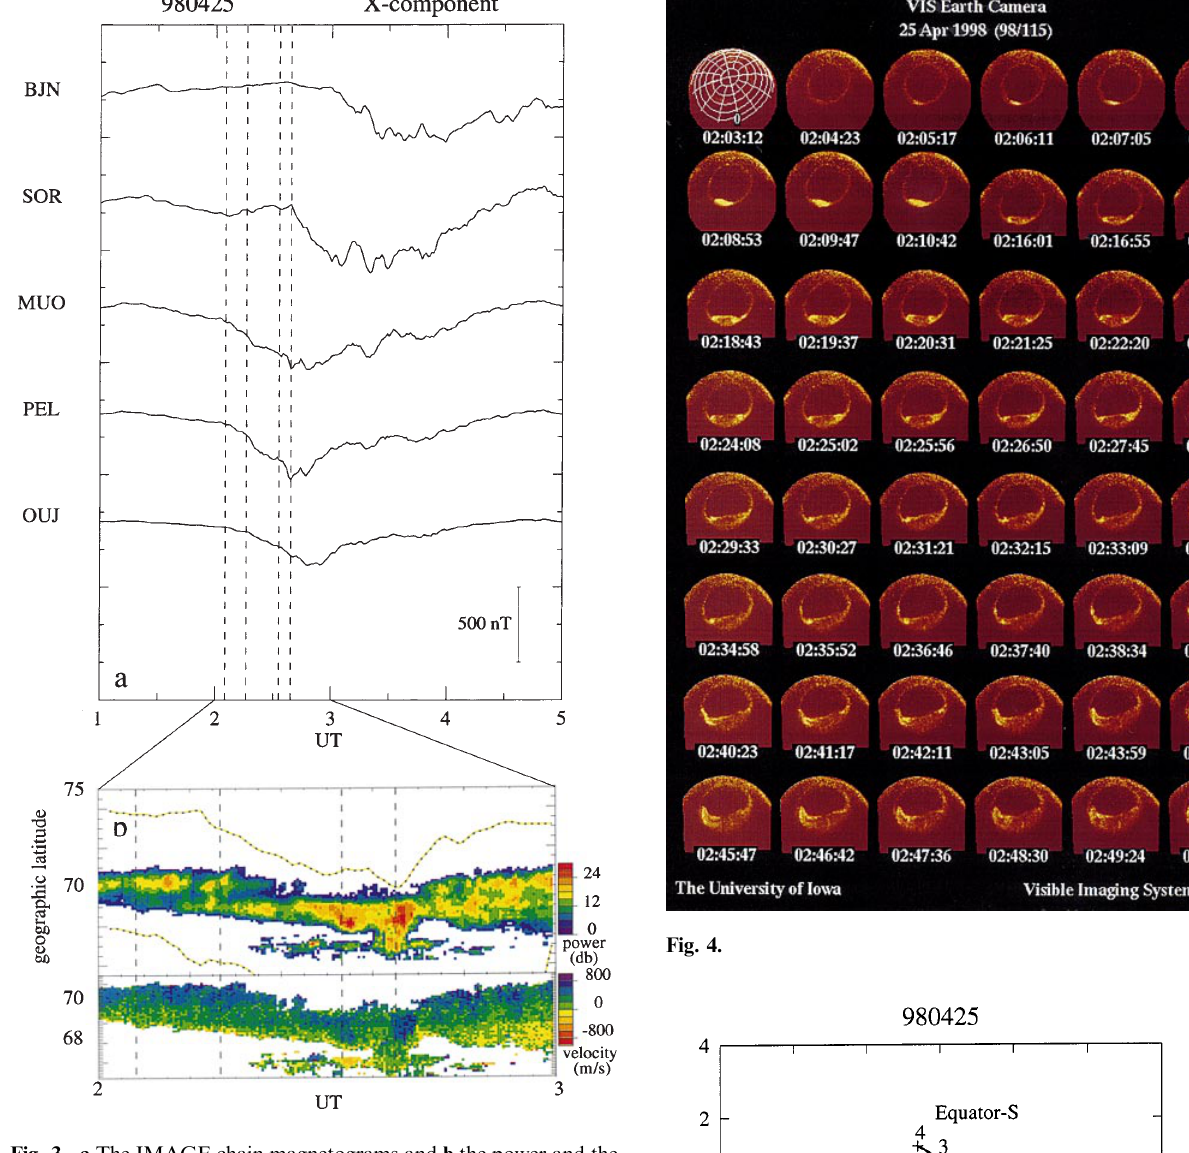
Fig. 3. a The IMAGE chain magnetograms and b the power and the line-of-sight velocity data from STARE data overlapped with the equatorward and poleward boundary of the westward electrojet ( dotted lines )